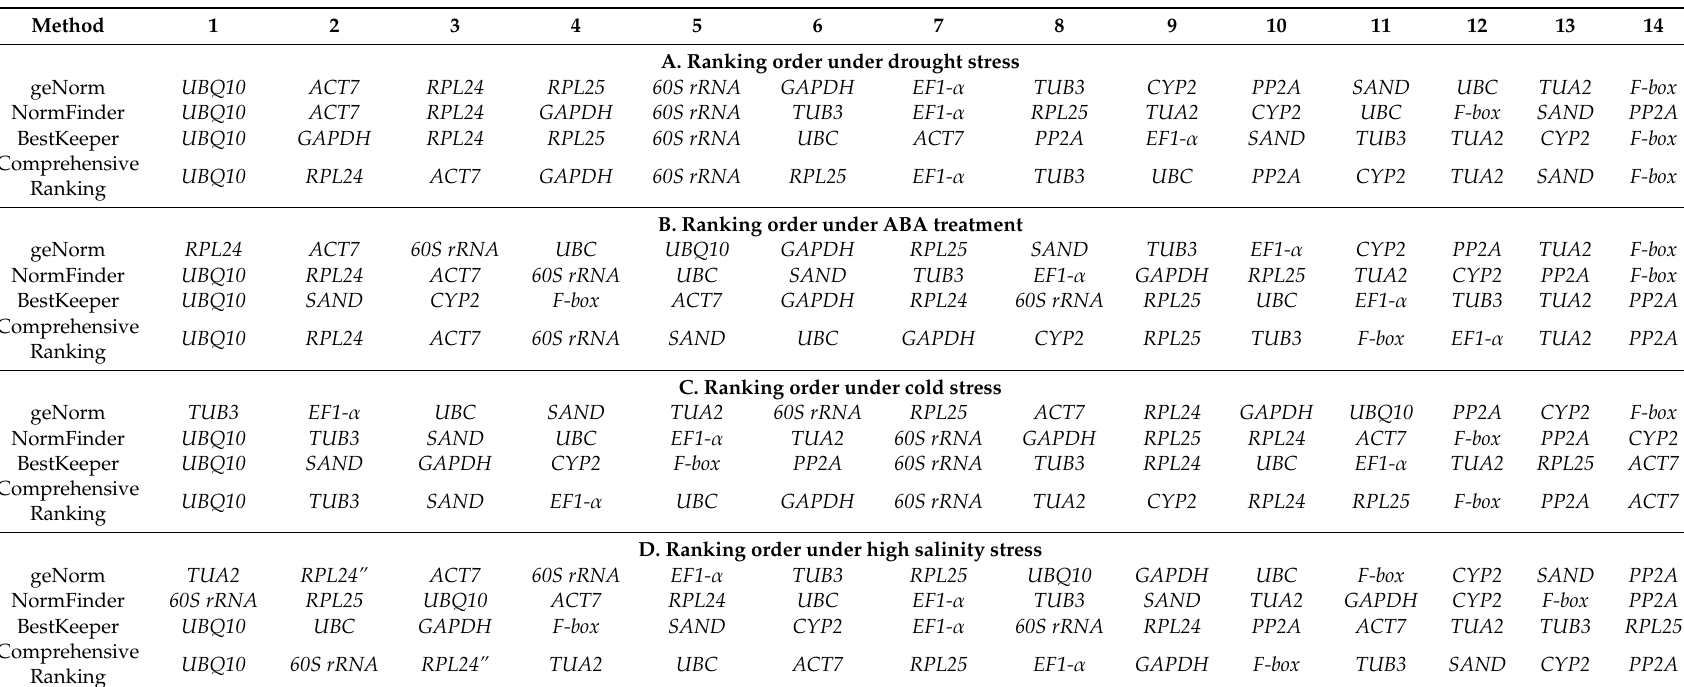
Table 5. Expression stability ranking of the 14 candidate reference